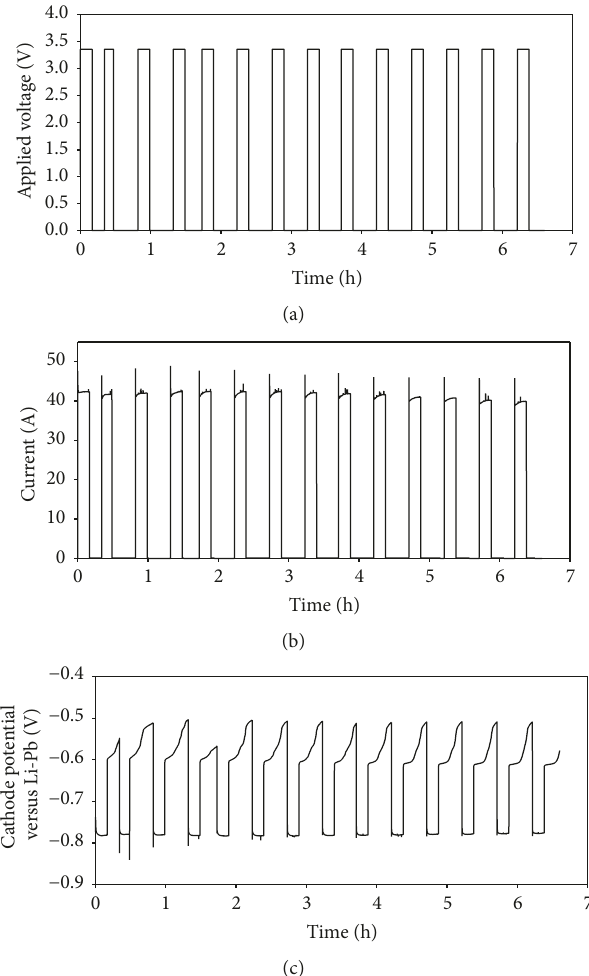
Figure 3: Electrolysis data: (a) applied voltage-time, (b) current- time, and (c) cathode potential-time.